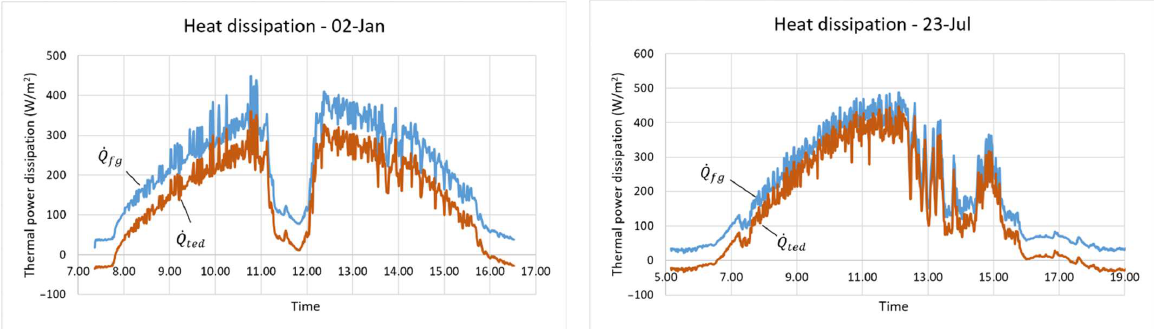
Figure 13. Temperature difference between PV cells and front glass/tedlar surfaces. Winter and summer conditions.